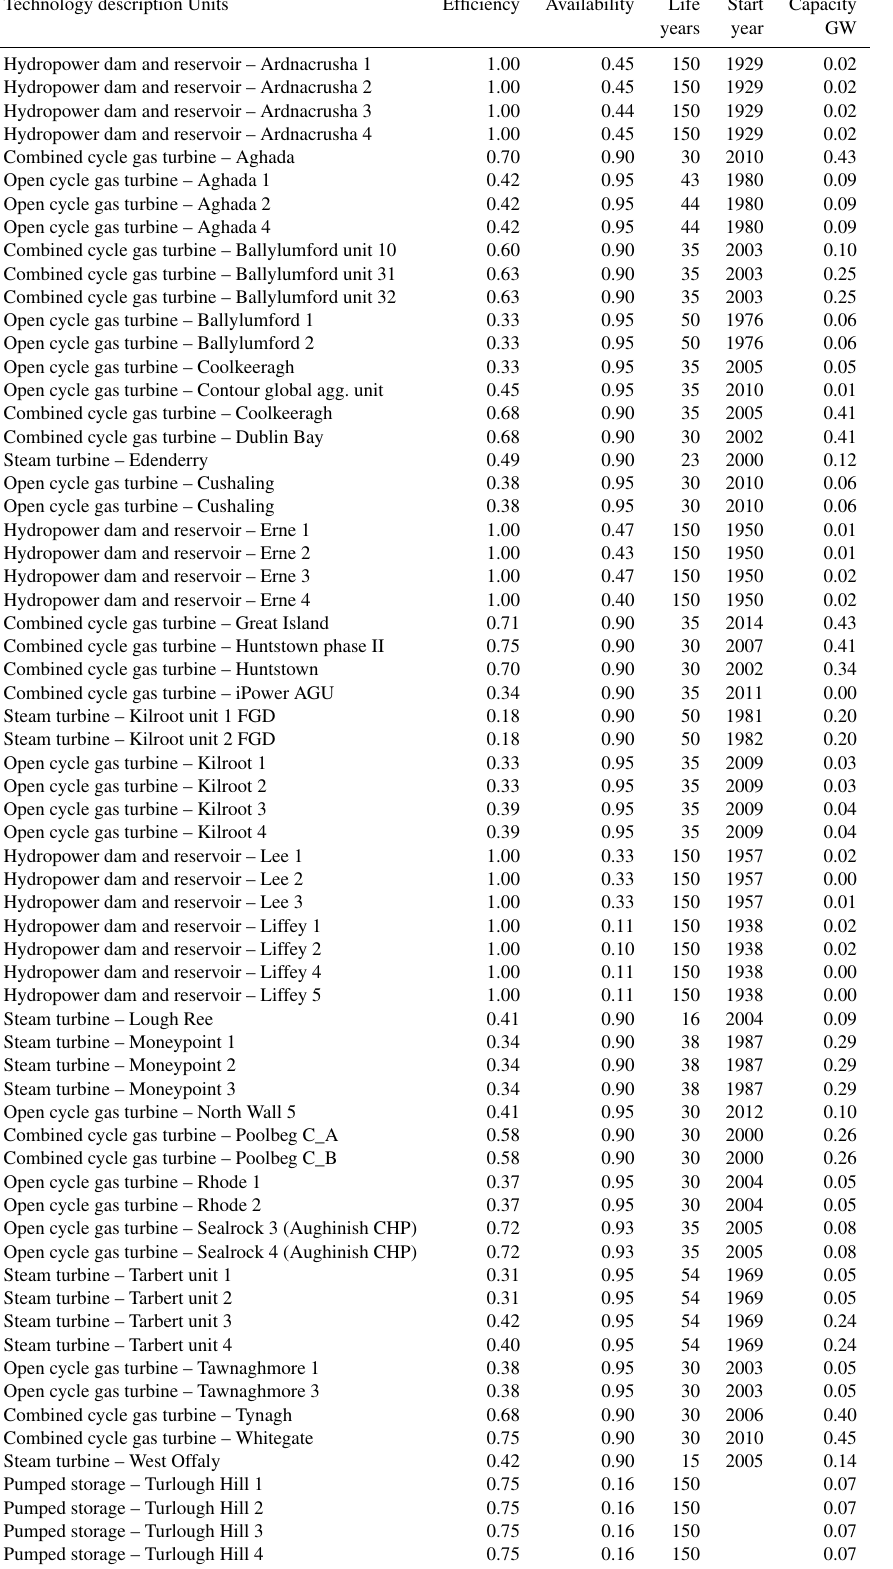
Table A5. Base year generation units. Technology description